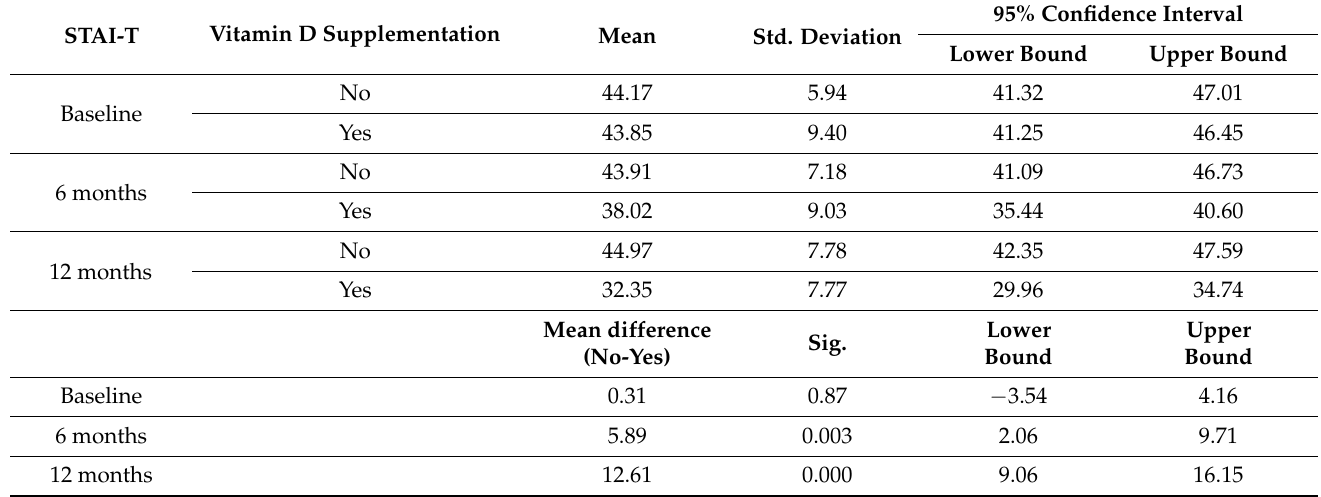
Table 2. Evolution of STAI-T scores and differences between the two groups throughout the study